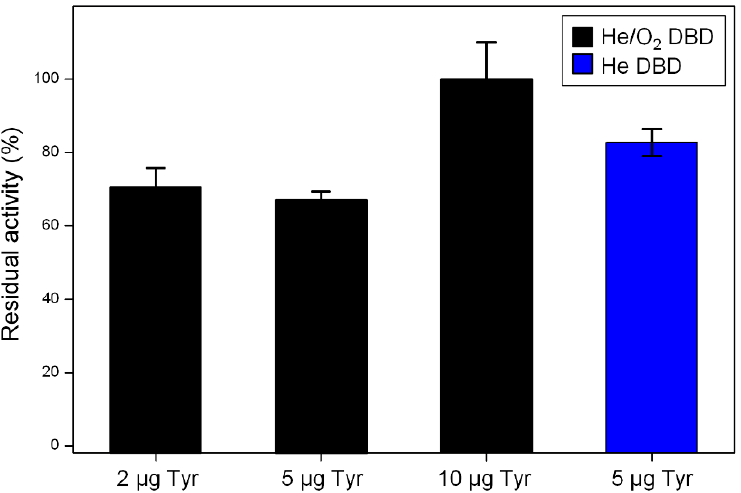
Figure 2. Tyrosinase residual activity after 30 min exposure to DBDs fed with He/1% O 2 mixture (Tyr amount = 2, 5, 10 μ g) and pure He (Tyr amount = 5 μ